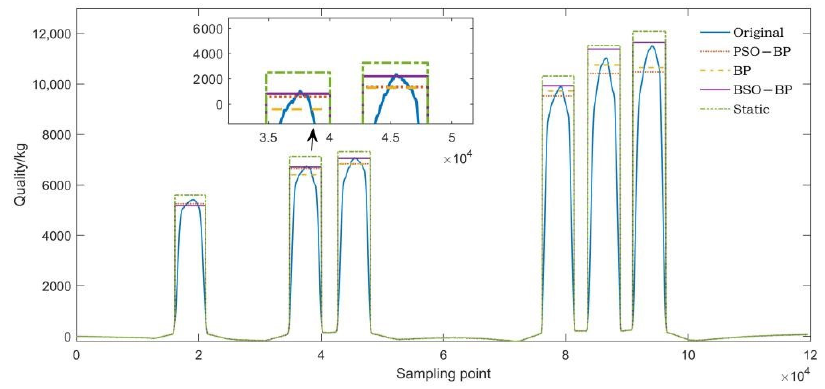
Figure 12. Corrected axle weight waveform comparison of a six-axle vehicle.